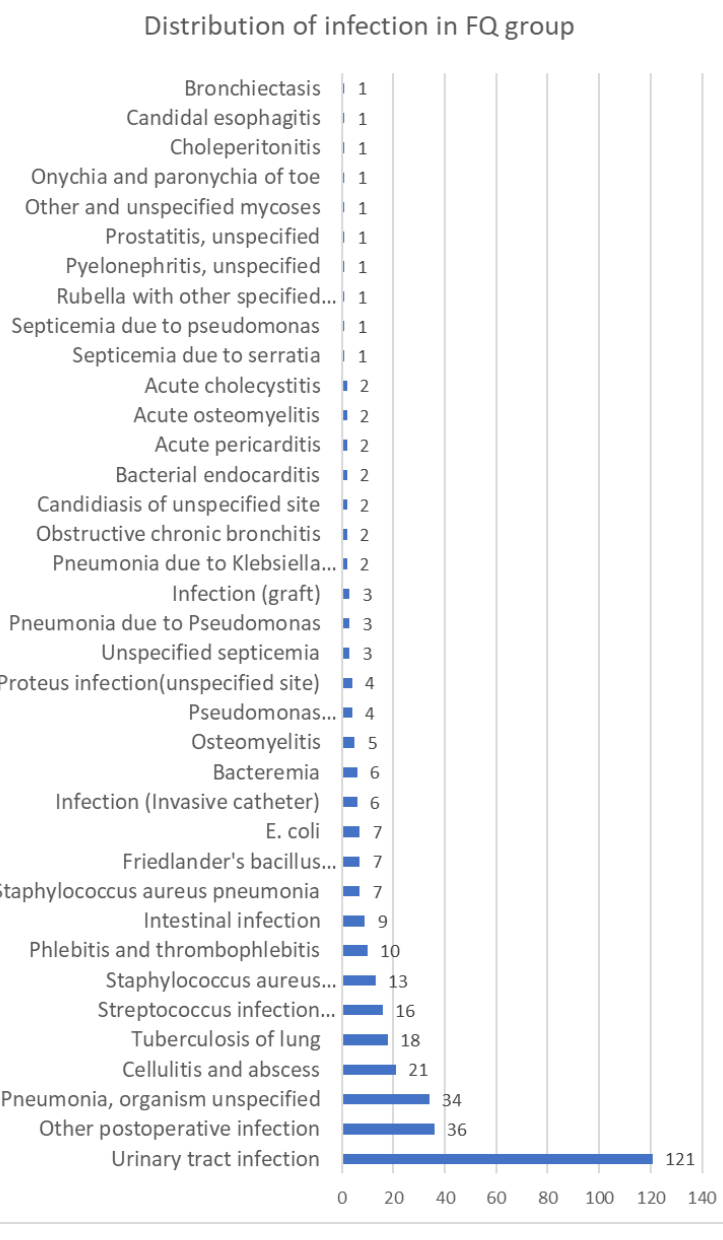
Figure 4. Distribution of infection in FQ group (some patients were diagnosed for several infec-